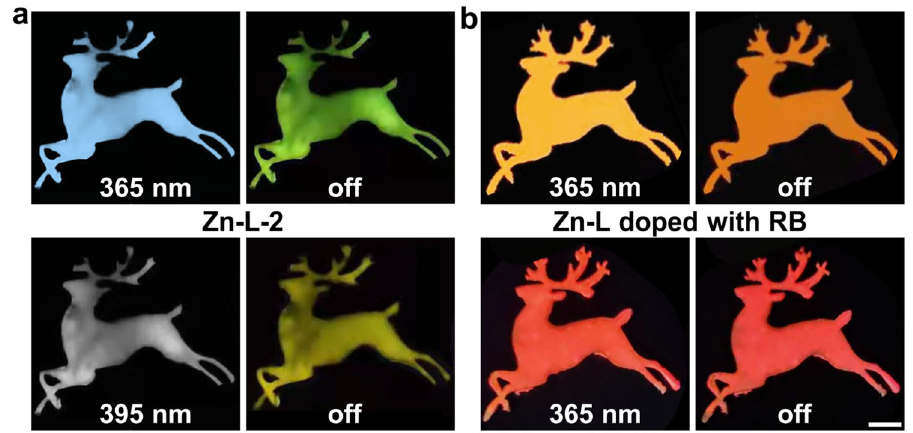
Fig. 7 | Demonstration of multicolored CPA emissions of SGs for the potential application in displays under ambient conditions.a The photos of Zn – L-2SGin the shape of a deer taken before and after 365/395nm irradiation turned off in